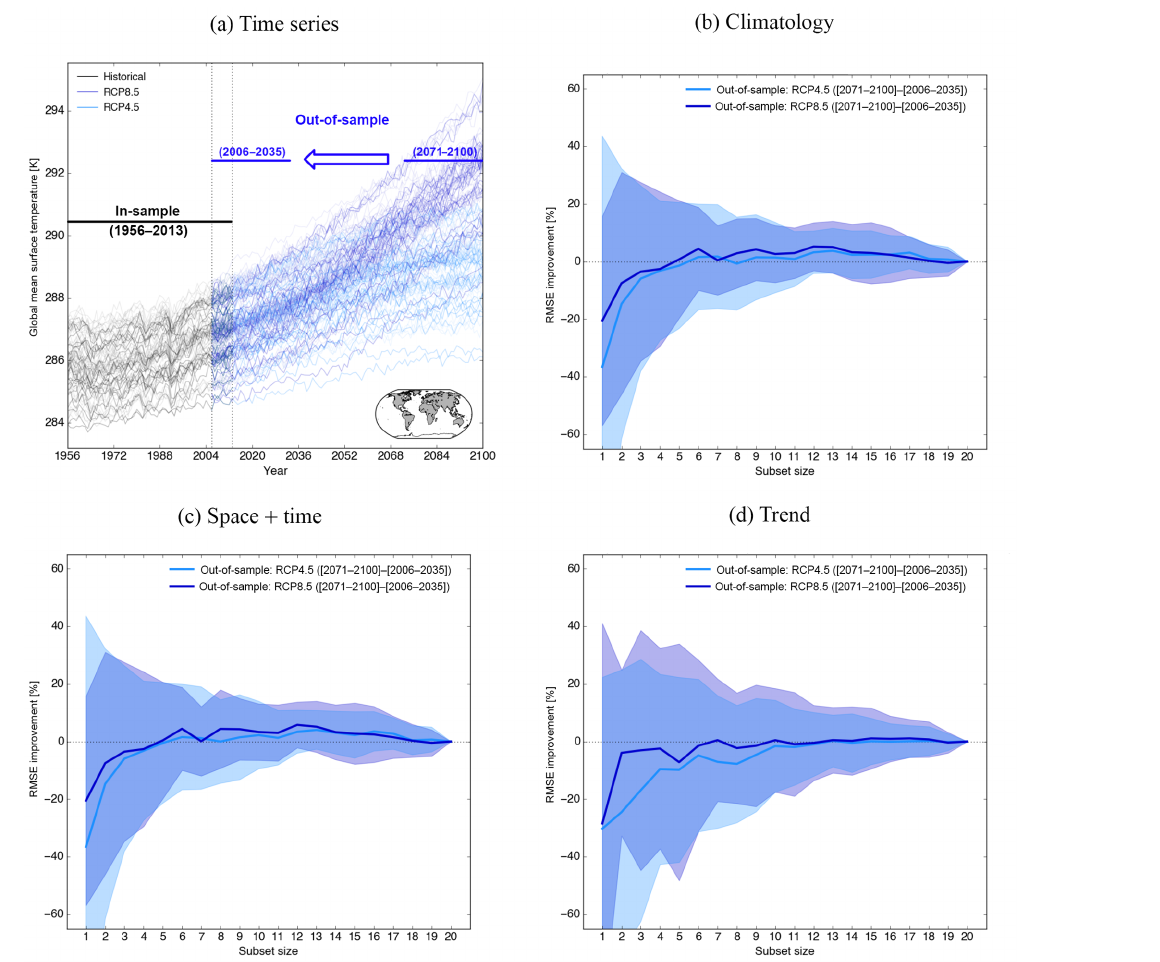
Figure 6. Similar to Fig. 4, but here we are trying to predict the (2071–2100)–(2006–2035) temperature change (a) based on the optimal subsets obtained with different metrics. For (b) – (d) the optimal ensembles obtained in-sample (1956–2013) are used to predict the surface air temperature change and compared to the “true” temperature change. The same is done with the MMM and then the RMSE improvement of the optimal subset relative to the one of the MMM is calculated for both RCP4.5 and RCP8.5. The curve is the mean across all models as truth and the shading is the spread around